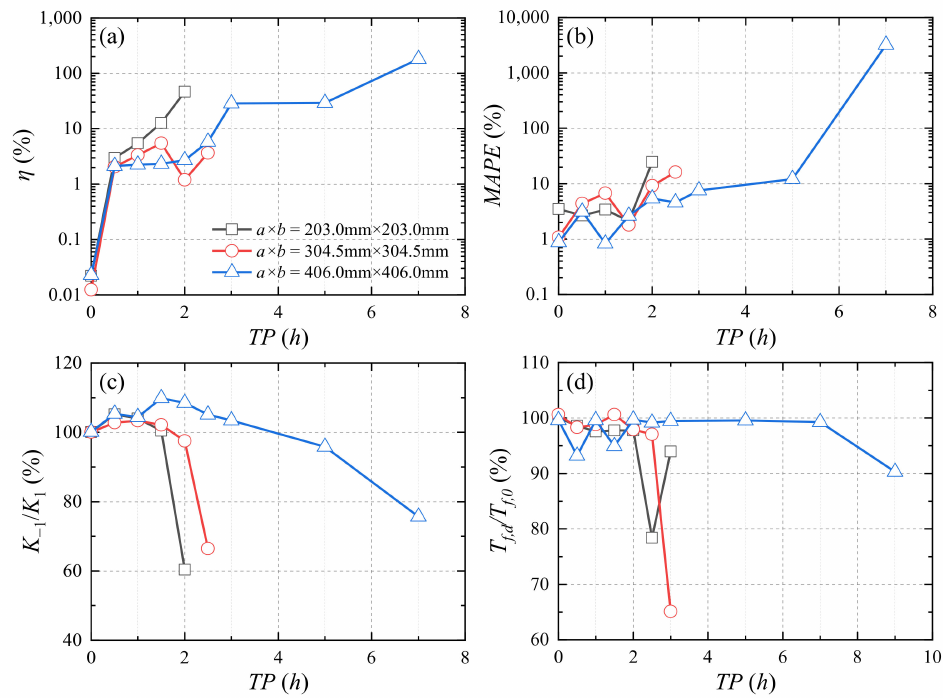
Figure 19. Impact of cyclic load on the response of different section size ( a × b ) of RC column during fire exposure: ( a ) cyclic load effect coefficient η ; ( b ) MAPE ; ( c ) stiffness degradation ratio; ( d ) fire resistance time